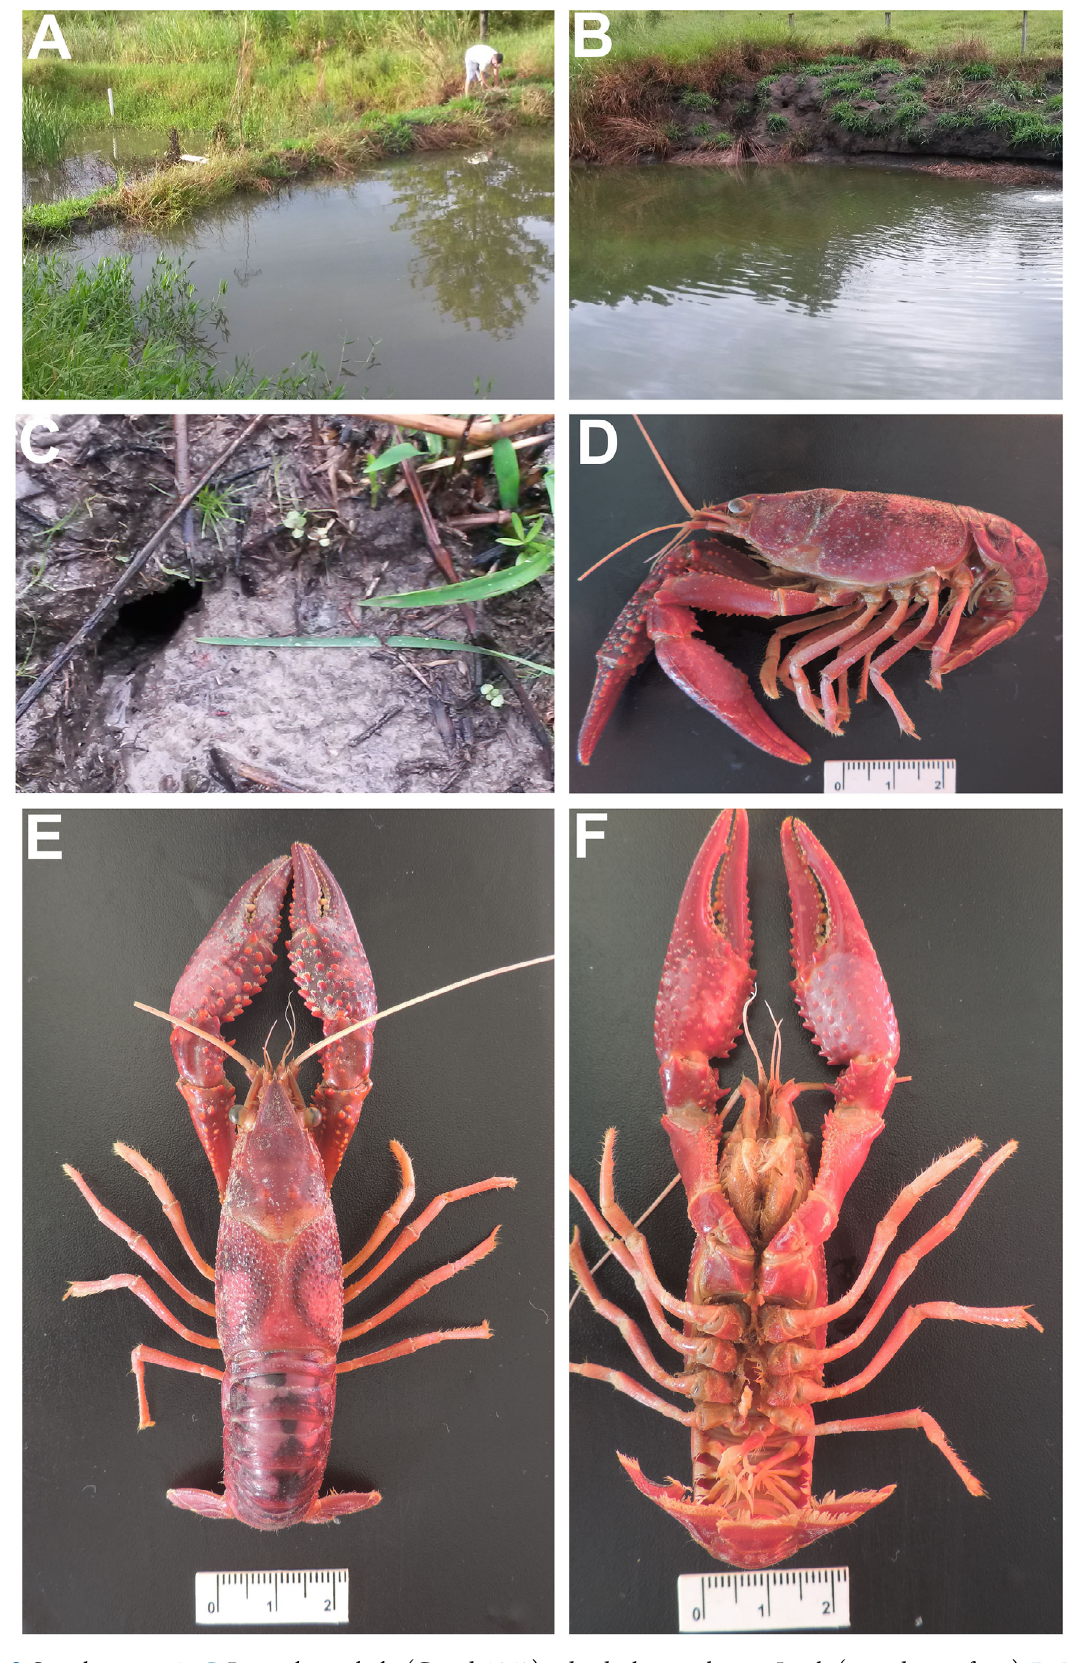
Figure 2. Sampling sites: A–C . Procambarus clarkii (Girard, 1852) individuals, morphotype I male (reproductive form): D–F , lateral, dorsal, and ventral views, respectively. Images by: Antunes,